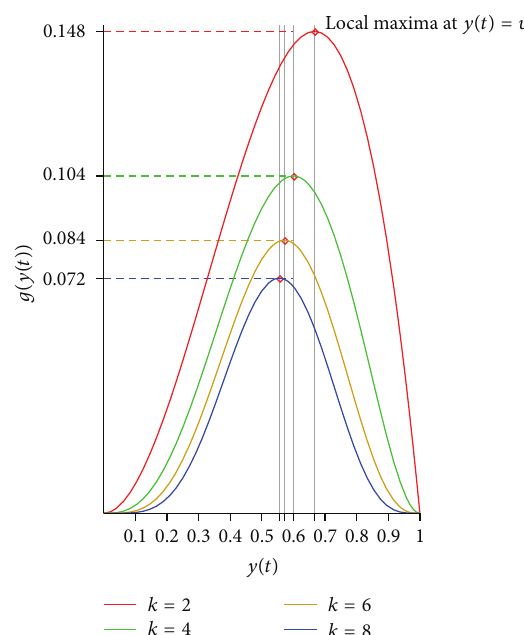
Figure 2: A plot of 𝑔(𝑦(𝑡)) as a function of 𝑦(𝑡) for even values of 𝑘